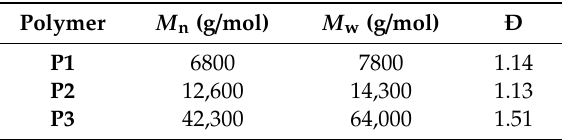
Table 2. Summary of the molar masses of the polymers P1 – P3 (molar mass was determined using size exclusion chromatography measurements (SEC); standard PMMA for P1 and P2 , polystyrene for P3